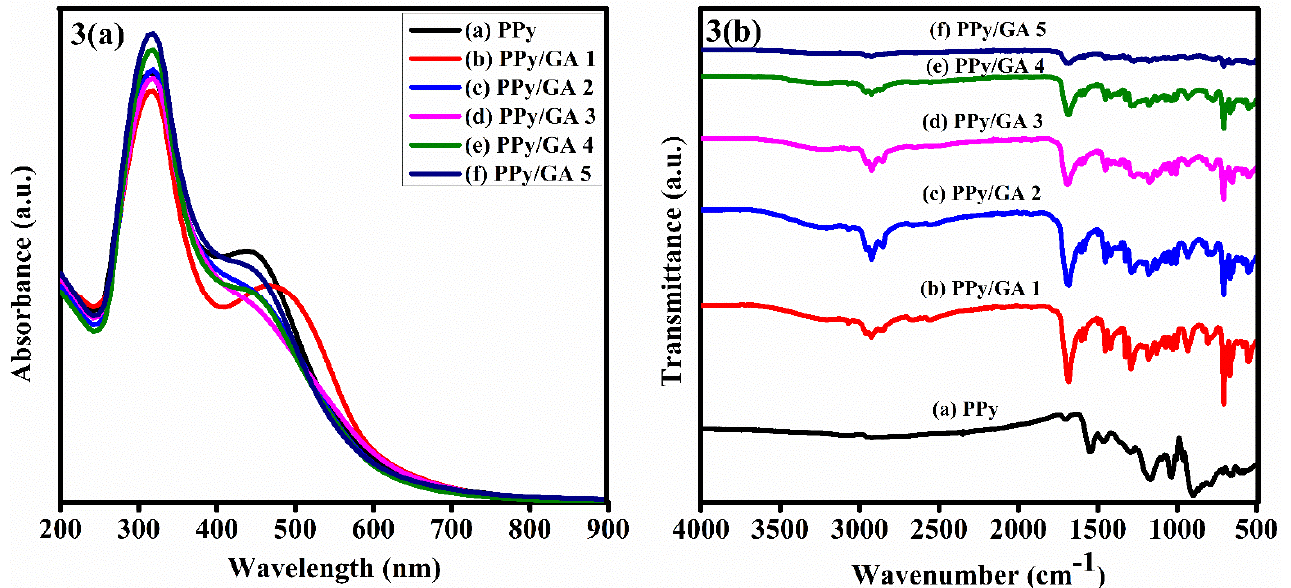
Figure 3. ( a ) UV-visible spectra of neat polypyrrole and its composites with gum arabic. ( b ) FTIR spectra of neat polypyrrole and its composites with gum arabic.